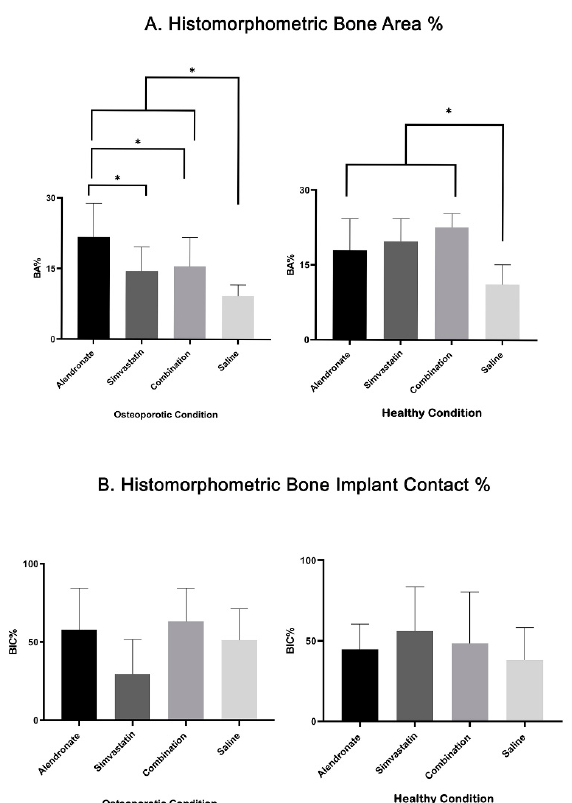
Figure 7. Bar-chart with mean and standard deviation, based on histomorphometric assessment, showing ( A ) bone area (BA%) and ( B ) bone-to-implant contact (BIC%) for all study groups. ( * indicates p < 0.05).